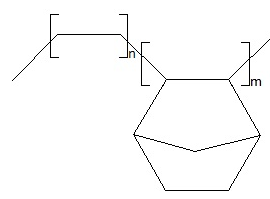
Figure 1. Ethylene-norbornene copolymer structure.